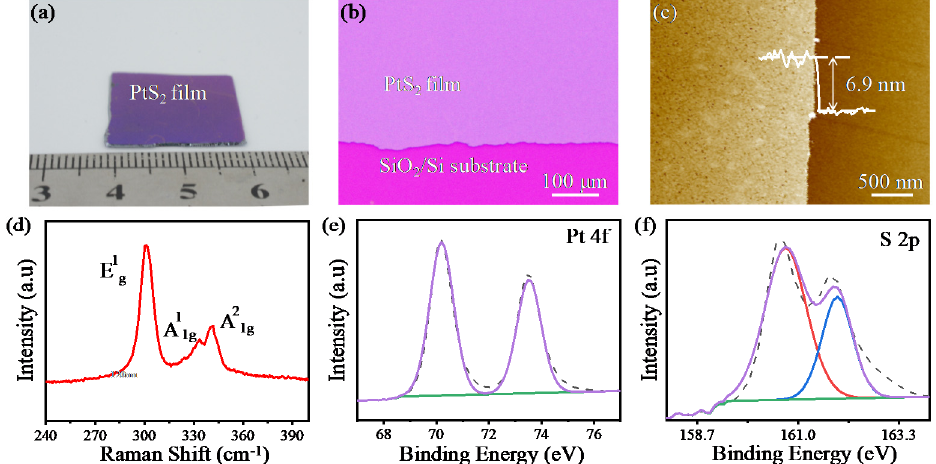
Figure 1. Characterization of continuous PtS 2 films. ( a – c ) Photograph, OM, and AFM images of CVD-grown PtS 2 continuous film, respectively. ( d – f ) Raman spectra and high resolution XPS spectra of Pt and S elements of as-obtained large-area PtS 2 film.